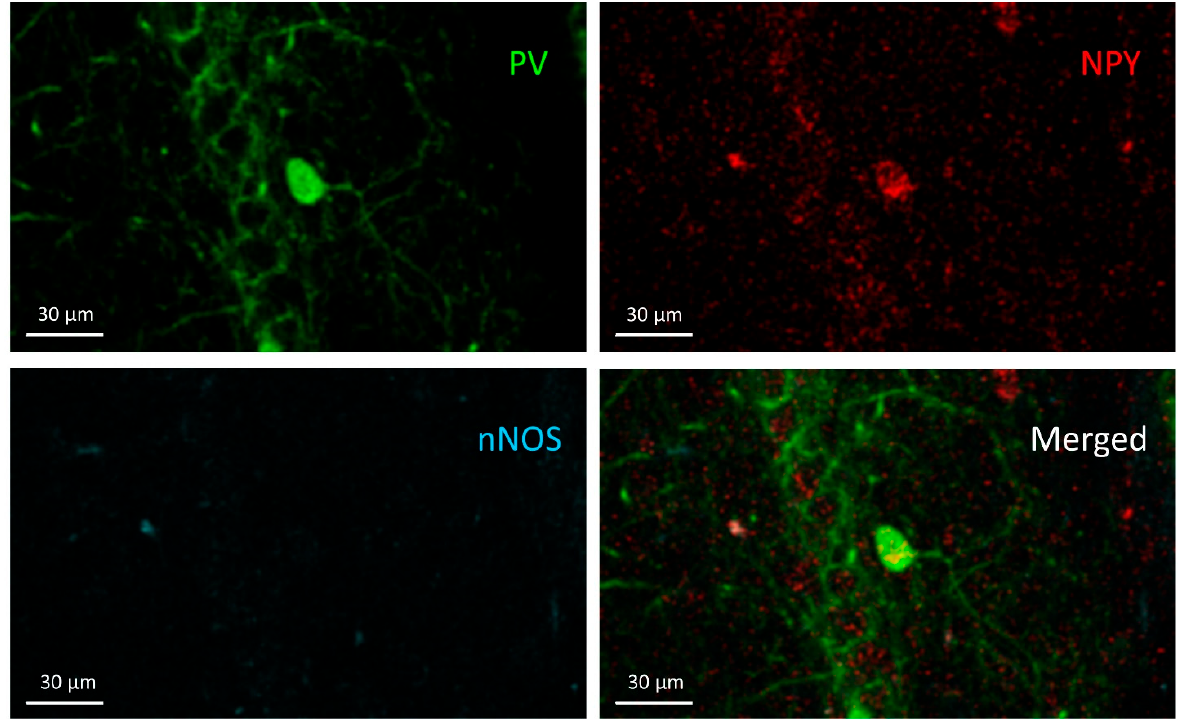
Figure 4. PV+/NPY+ cell; the cell can be seen in the PV (green) and NPY (red) channels in the stratum pyramidale but does not appear in the nNOS channel.